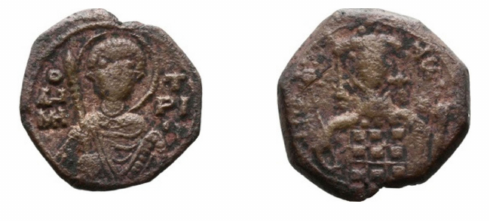
Figure 10. First Indiction Tetaraton, 1118–1122; impression on copper; Oxford; HCR53126. Published at [15] ( DOC , pp. 224, 226, 228, 231, 234, 248–249, 264–267. Images on Plates VIII-X),